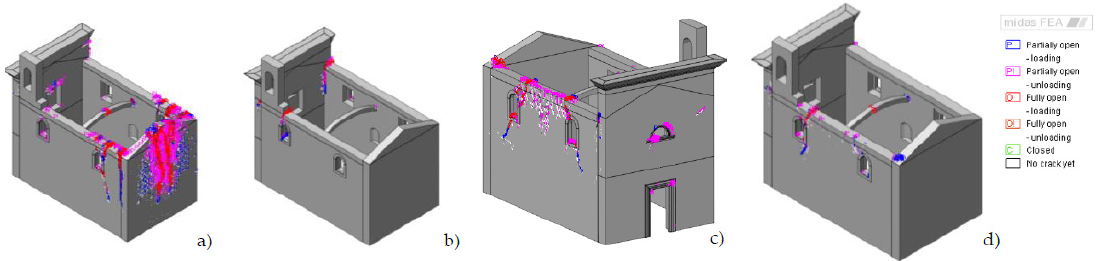
Figure 16. Numerical damage for Santissimo Crocifisso in Arquata del Tronto (Ascoli Piceno, Central Italy) for PushMass + x ( a ), PushMass − x ( b ), PushMass + y ( c ), PushMass − y ( d ).